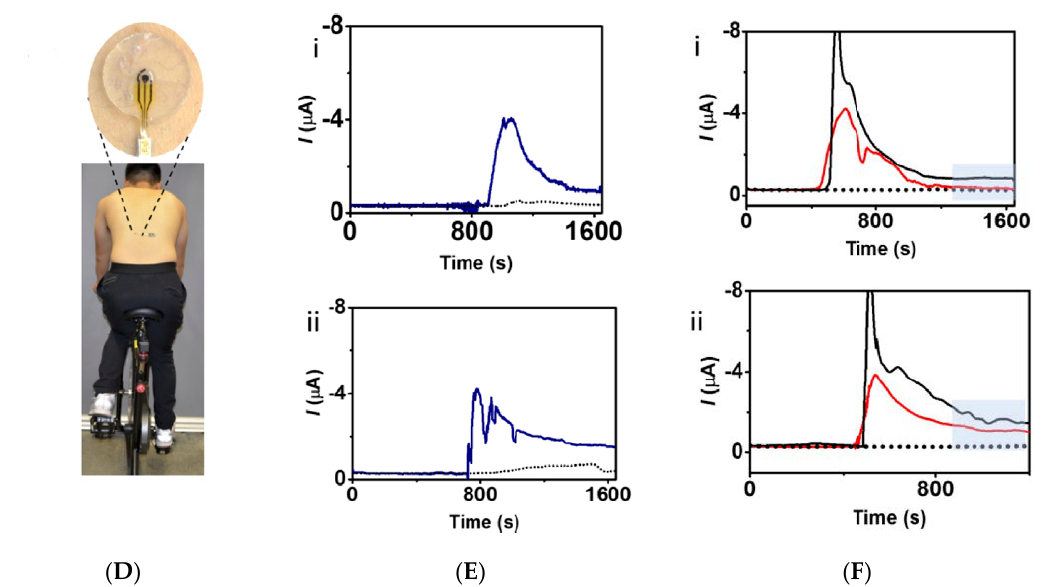
Figure 12. ( A ) Scheme of the three-layer device: (i) top PDMS layer carrying sensing electrodes; (ii) middle PDMS layer carrying microfluidics; (iii) adhesive layer in contact with the skin. ( B ) Sweat collection. ( C ) Device integrated with wireless flexible electronics. Scale bar: 5 mm. ( D ) Position of the sensor on the back of the subject during effort. ( E ) Continuous lactate monitoring with (blue full line) and without (dotted line) lactate oxidase for (i) subject 1 and (ii) subject 2. ( F ) Continuous glucose monitoring before (red full line) and after meal (black full line) with glucose oxidase and without (dotted line) for (i) subject 1 and (ii) subject 2. Amperometric experiments were carried out at − 0.1 V vs. Ag/AgCl during physical exercise, and all data were wirelessly transmitted to a computer. Reproduced from [34] with permission. Copyright © 2017 American Chemical Society.